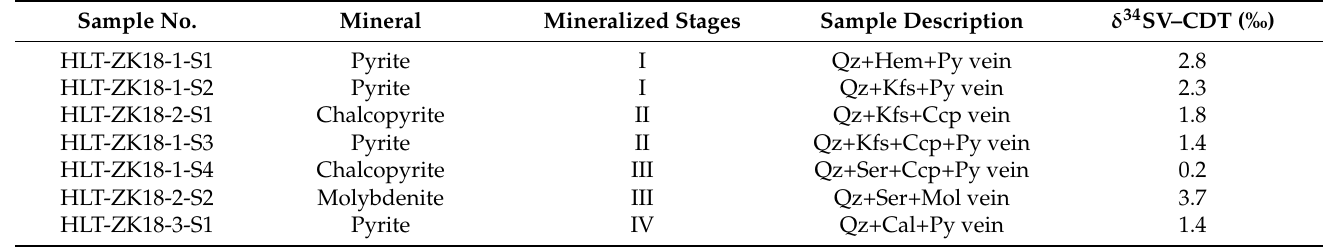
Table 4. S isotope data of sulfide samples from the Huoluotai Cu (Mo) deposit. Sample